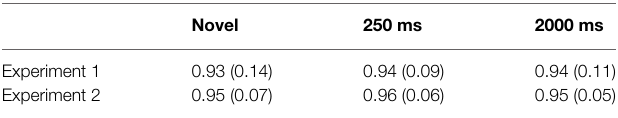
TABLE 1 | Mean response accuracy in each condition.